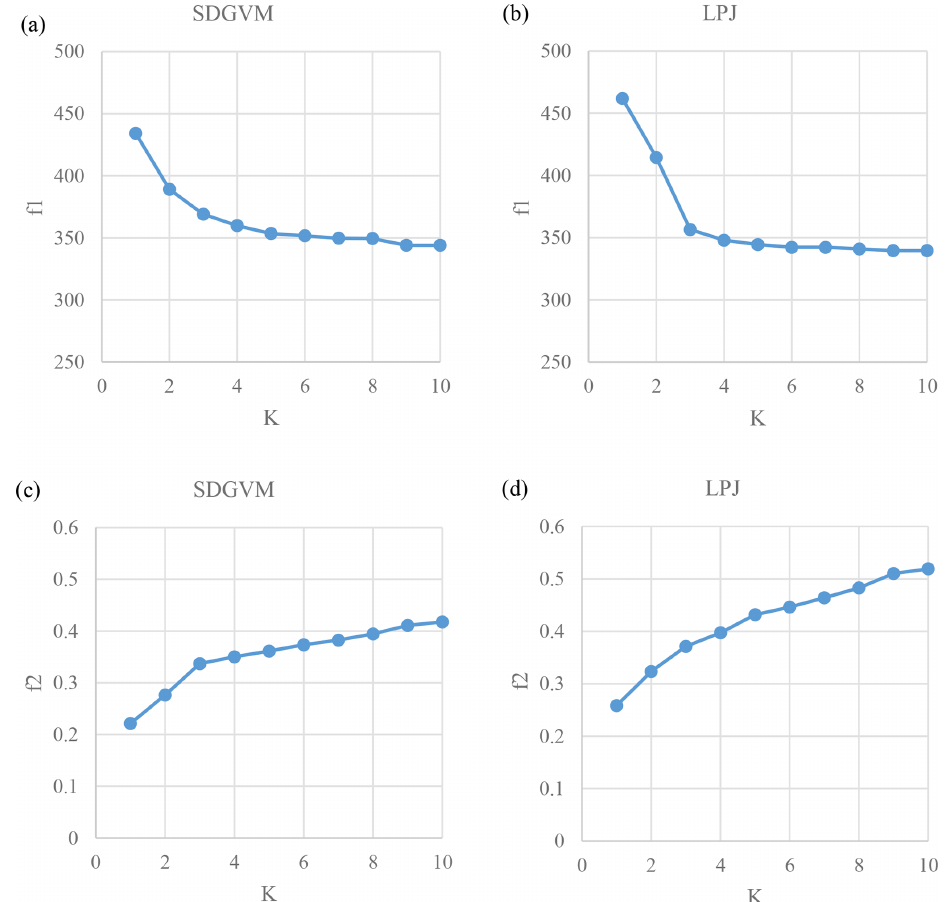
Figure 6. Variations of statistics for a match between Eocene max K NN predicted high FW and coal locations (Boucot et al., 2013). The f1 is the mean distance of a coal location to site with FW > 0 . 2 for model based on (a) SDGVM and (b) LPJ. The f2 is the mean FW of sites within 2 pixels of a coal location for model based on (c) SDGVM and (d) LPJ data.